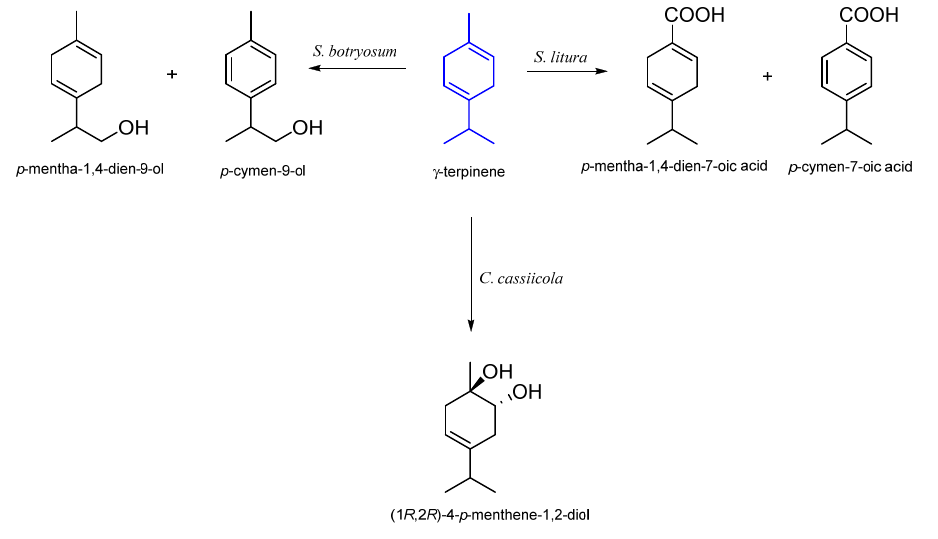
Scheme 6. Biotransformation of racemic γ -terpinene. Table 3. Biotransformation of γ -terpinene.